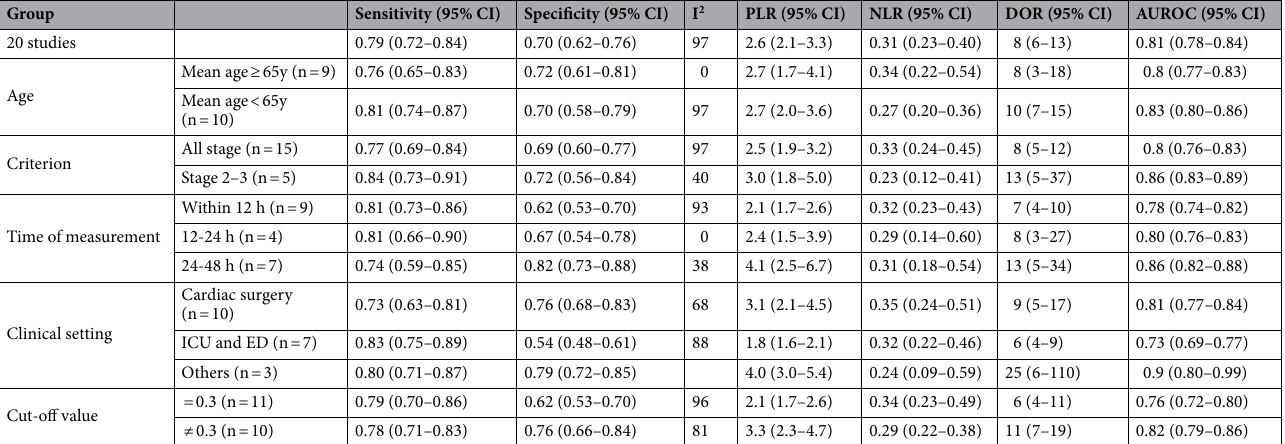
Table 2. Results of subgroup analysis based on different standards. AUROC area under the receiver operating characteristic curve, CI confidence interval, DOR diagnostic odds ratio, ED emergency department, ICU intensive care unit, PLR positive likelihood ratio, NLR negative likelihood